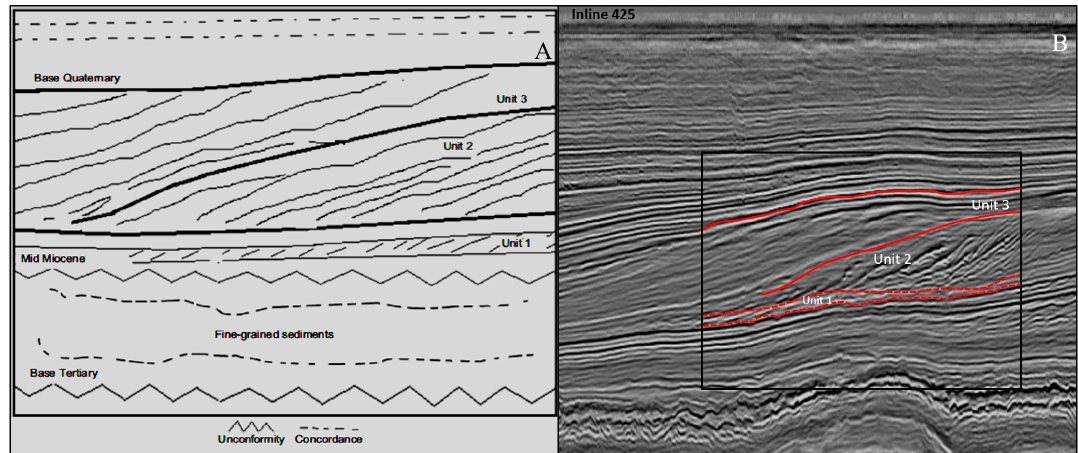
Figure 3. ( A ) The schematic diagram of the Neogene Eridanos fluvio-deltaic system of the North Sea and ( B ) its corresponding seismic profile (inline 425). The Eridanos delta can be divided into the Upper and Lower packages. The Upper package can be further divided into 3 sub-unit [30].